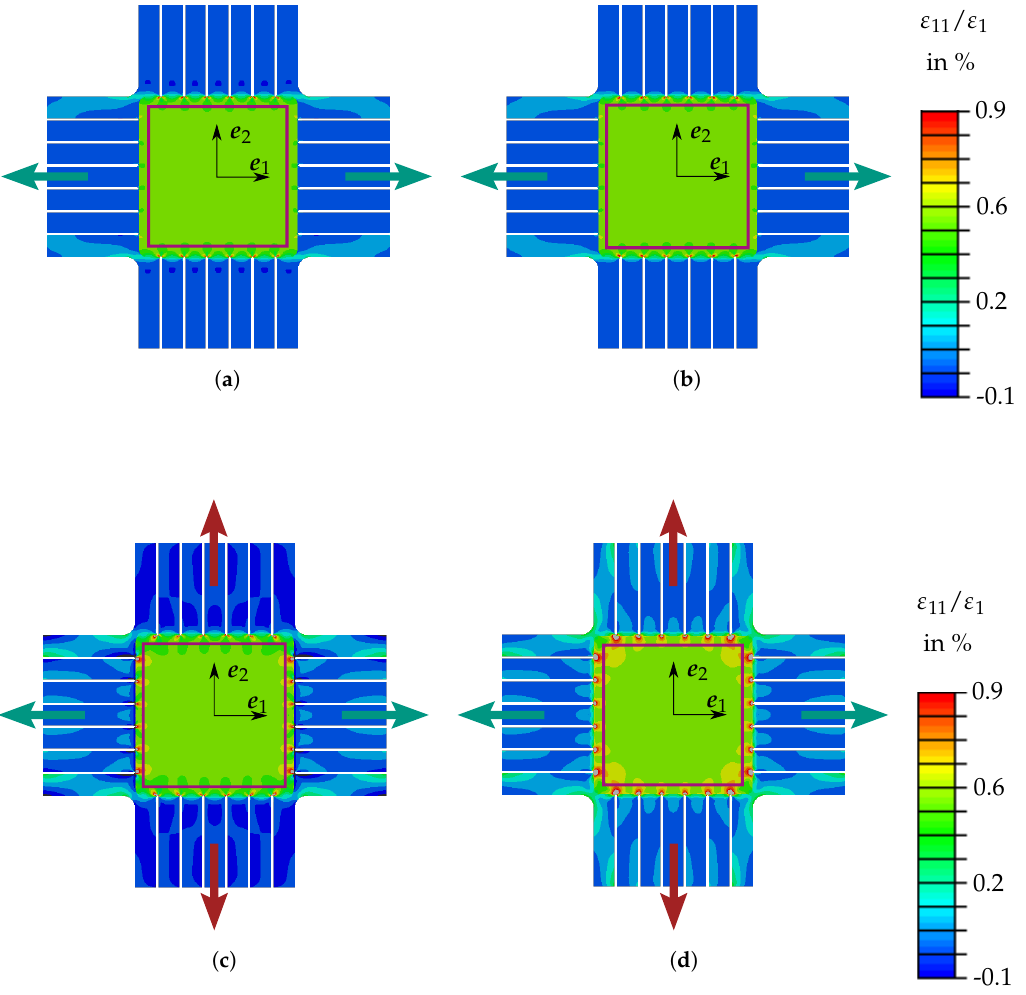
Figure 12. FE (finite element) results for geometry 1 specimen at a macroscopic strain of ¯ ε I The strain fields show the normal strain ε 11 and the largest principal strain ε 1 . ( a ) ε 11 for uniaxial load in e 1 -direction; ( b ) ε 1 for uniaxial load in e 1 -direction; ( c ) ε 11 for equi-biaxial load; ( d ) ε 1 for equi-biaxial